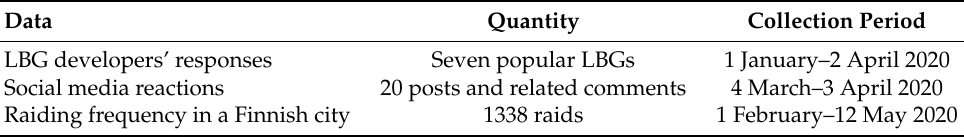
Table 2. Summary of collected